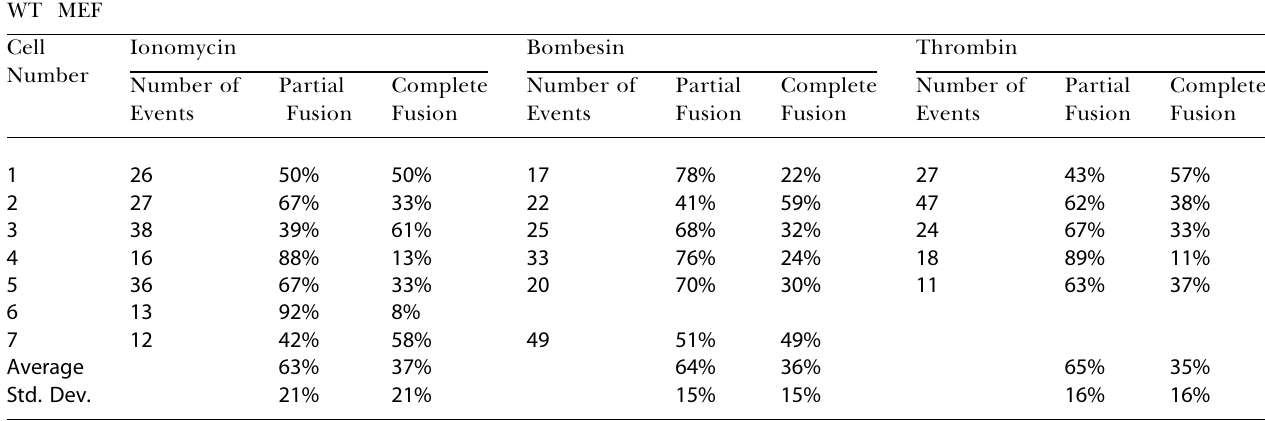
Table 1. Nature of Release of Lysosomal Lumenal Content WT MEF